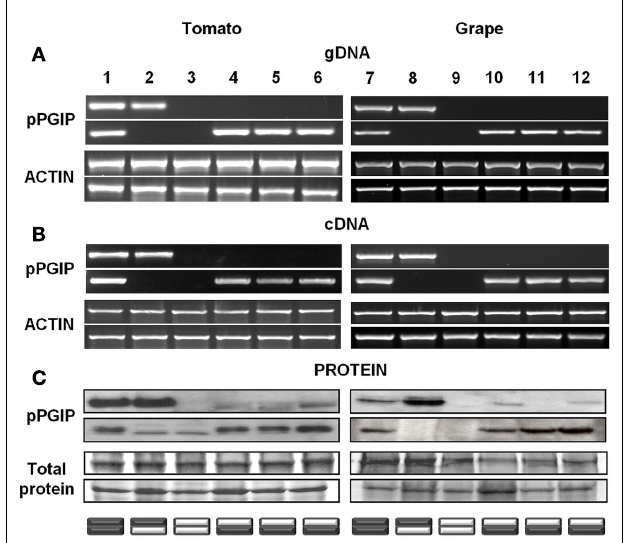
FIGURE 1 | PCR products from tomato and grape leaf tissues using (A) genomic DNA and (B) reverse transcribed mRNA (cDNA). Actin gene from each respective species was used as a positive control.Western blots (C) of protein extracts taken from scion and rootstock leaf tissues. Coomassie-stained total protein is used as a loading control. pPGIP is visualized with a polyclonal antibody whose limit of detection is 40ng of protein.The pPGIP protein detected in the scion leaves has moved from transgenic rootstocks into wild-type (WT) scion tissue (lanes 4–6, 10, 12). This movement is not seen in the reciprocal graft (lanes 2, 8). Movement was not detected in grape scion (lane 11), though present in the rootstock. Cross-reactivity of the pPGIP antibody to wild-type tomato tissue can be observed in lanes 2 and 3 (rootstock), but these bands do not match the size of the transgenic pPGIP. Graft combinations are represented by stacked rectangles (bottom = rootstock; top = scion) with dark boxes representing transgenic portions of the plant and light boxes representingWT.